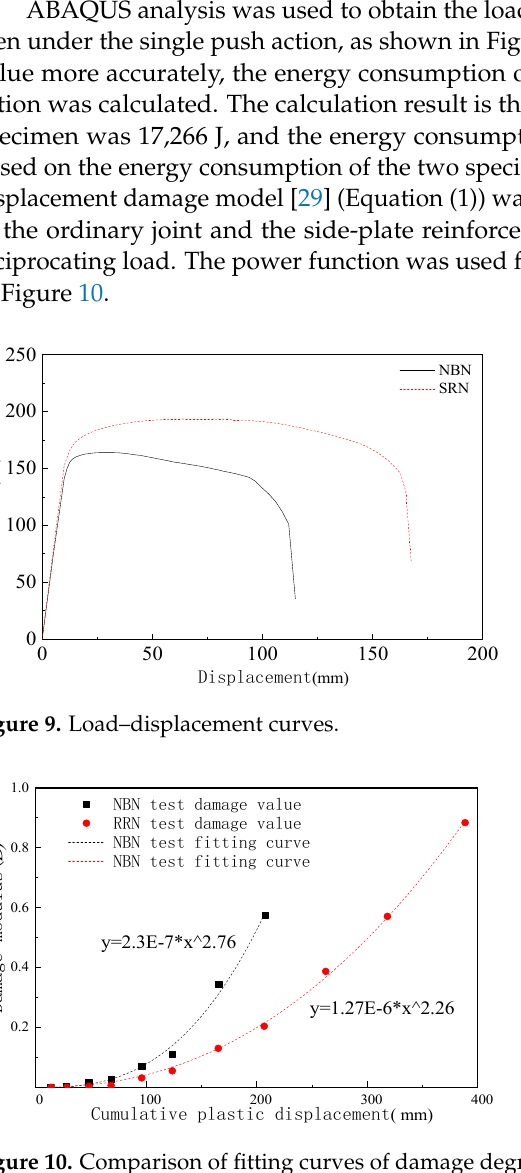
Figure 10. Comparison of fitting curves of damage degradation.